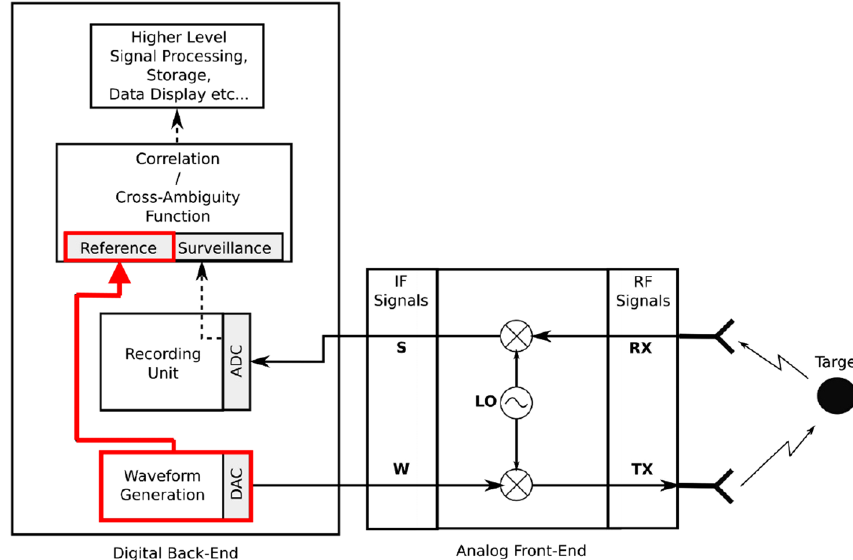
Fig. 14 Block diagram of a continuous emission noise radar. Solution (a): the reference is the digital record of the transmitted